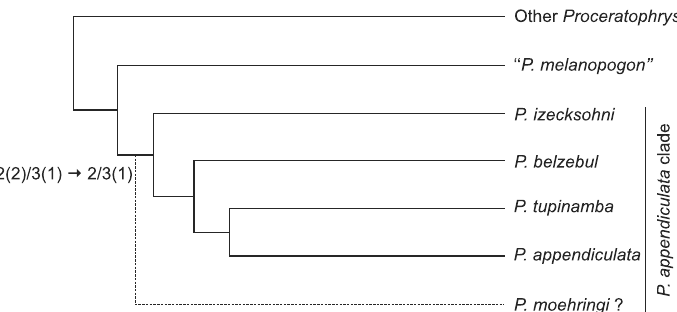
Figure17. Hypothesis of phylogenetic relationships within Proceratophrys (D IAS et al . 2013a). The evolutionary transition of the oral formula 2(2)/3(1) to 2/ 3(1) is a putative synapomorphy for this clade. The phylogenetic position of P. moehringi (dotted line) had remained unknown before. However, adult morphology, advertisement call and breeding behavior suggest a close rela- tionship with P. appendiculata (D IAS et al .